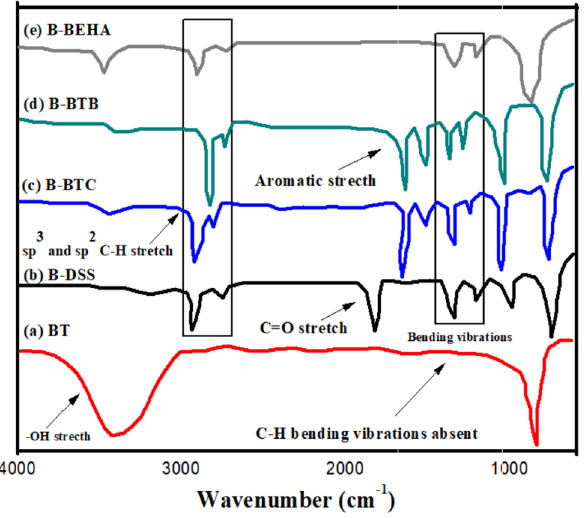
Figure 1. FT-IR spectrum of ( a ) unmodified bentonite and modified bentonite, ( b ) B-DSS, ( c ) B-BTC, ( d ) B-BTB and ( e )